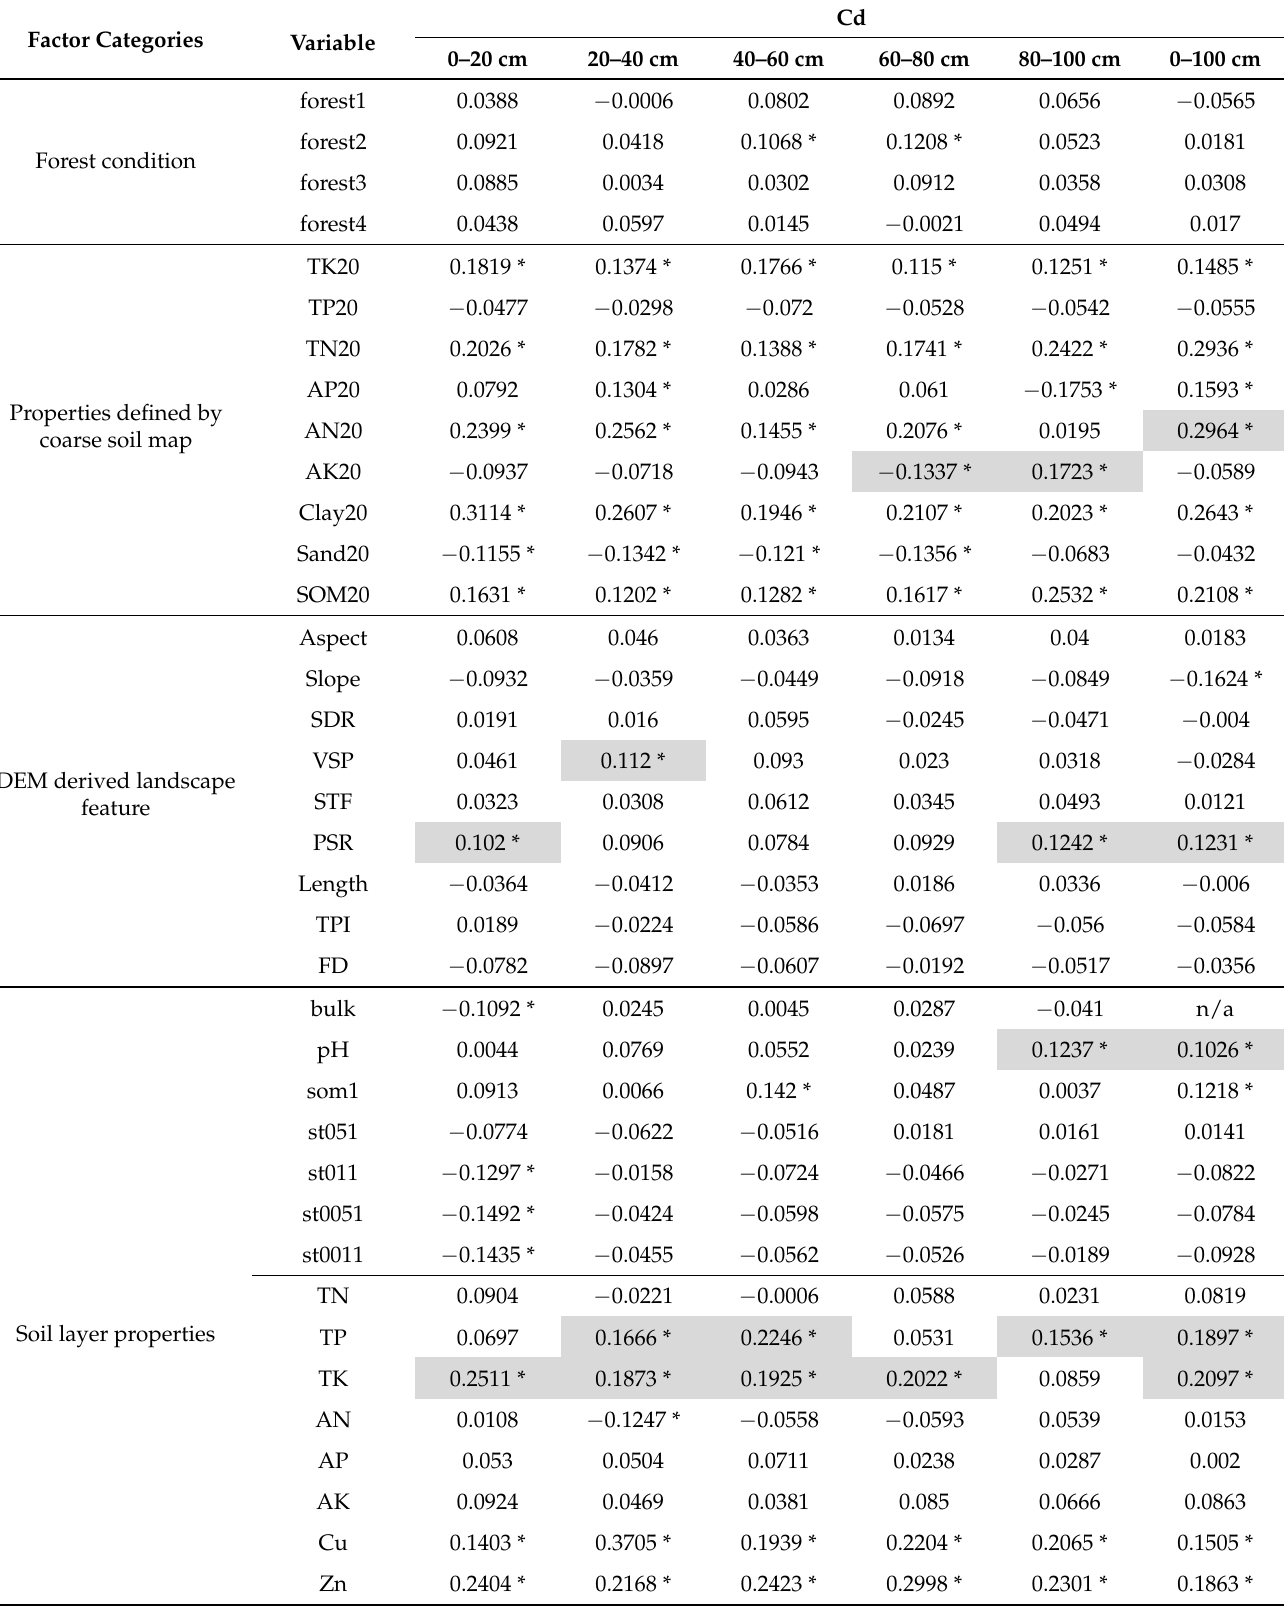
Table 4. Pearson correlation between Cd concentration and surface soil properties from the coarse soil map and soil layer properties measured in soil samples at different